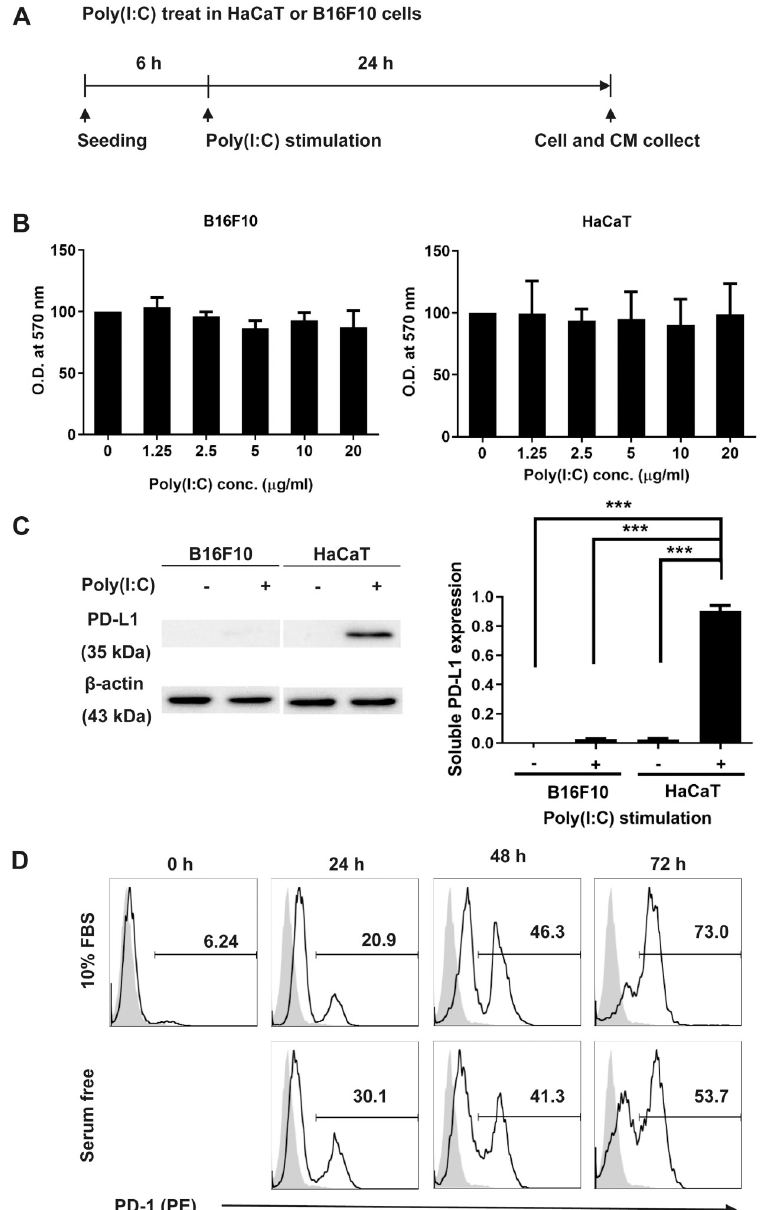
Fig 1. Poly(I:C) stimulation increases PD-L1 secretion from HaCaT cells. (A) HaCaT or B16F10 cells and CM were collected following incubation with 20 ng/mL poly(I:C) for 24 h. (B) Cell viability was measured by MTT assay. (C) PD-L1 levels in CM from B16F10 and HaCaT cultures, assessed by immunoblotting. PD-L1 levels were normalized to β -actin levels using pixel densities. (D) B16F10 cells were cultured in DMEM with or without FBS for � 72 h. Data are presented as mean ± SD and were analyzed by one-way ANOVA ( ��� P < 0.001).